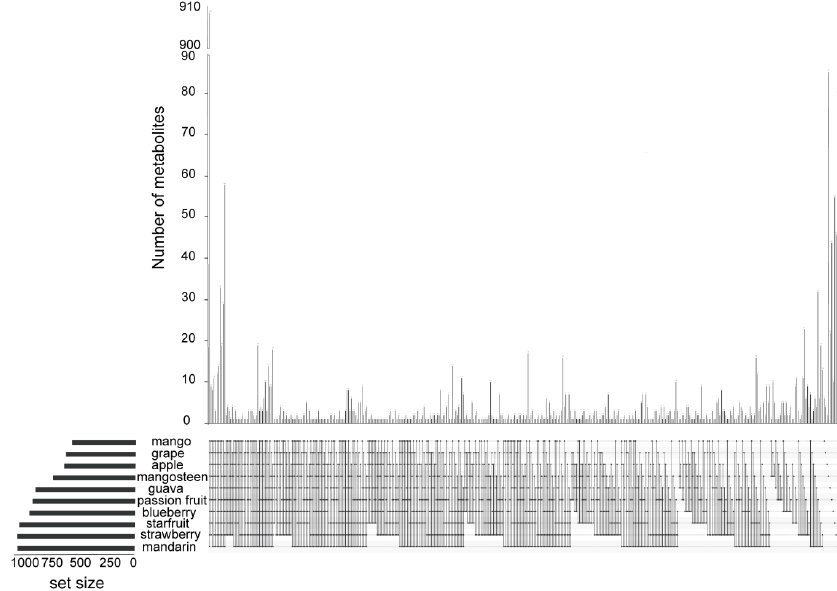
Figure 3. An upset plot of the number of metabolites detected in ten kinds of fruits. Black dot(s) at the bottom of each vertical bar indicates the intersection, which is made up of fruits that share the same metabolite. The lined dots indicate that two or more fruits shared the same metabolites. The black vertical bars at the top of the diagram indicate the number of metabolites of the corresponding intersection. The total numbers of metabolites detected in each fruit are represented by horizontal bars on the left.